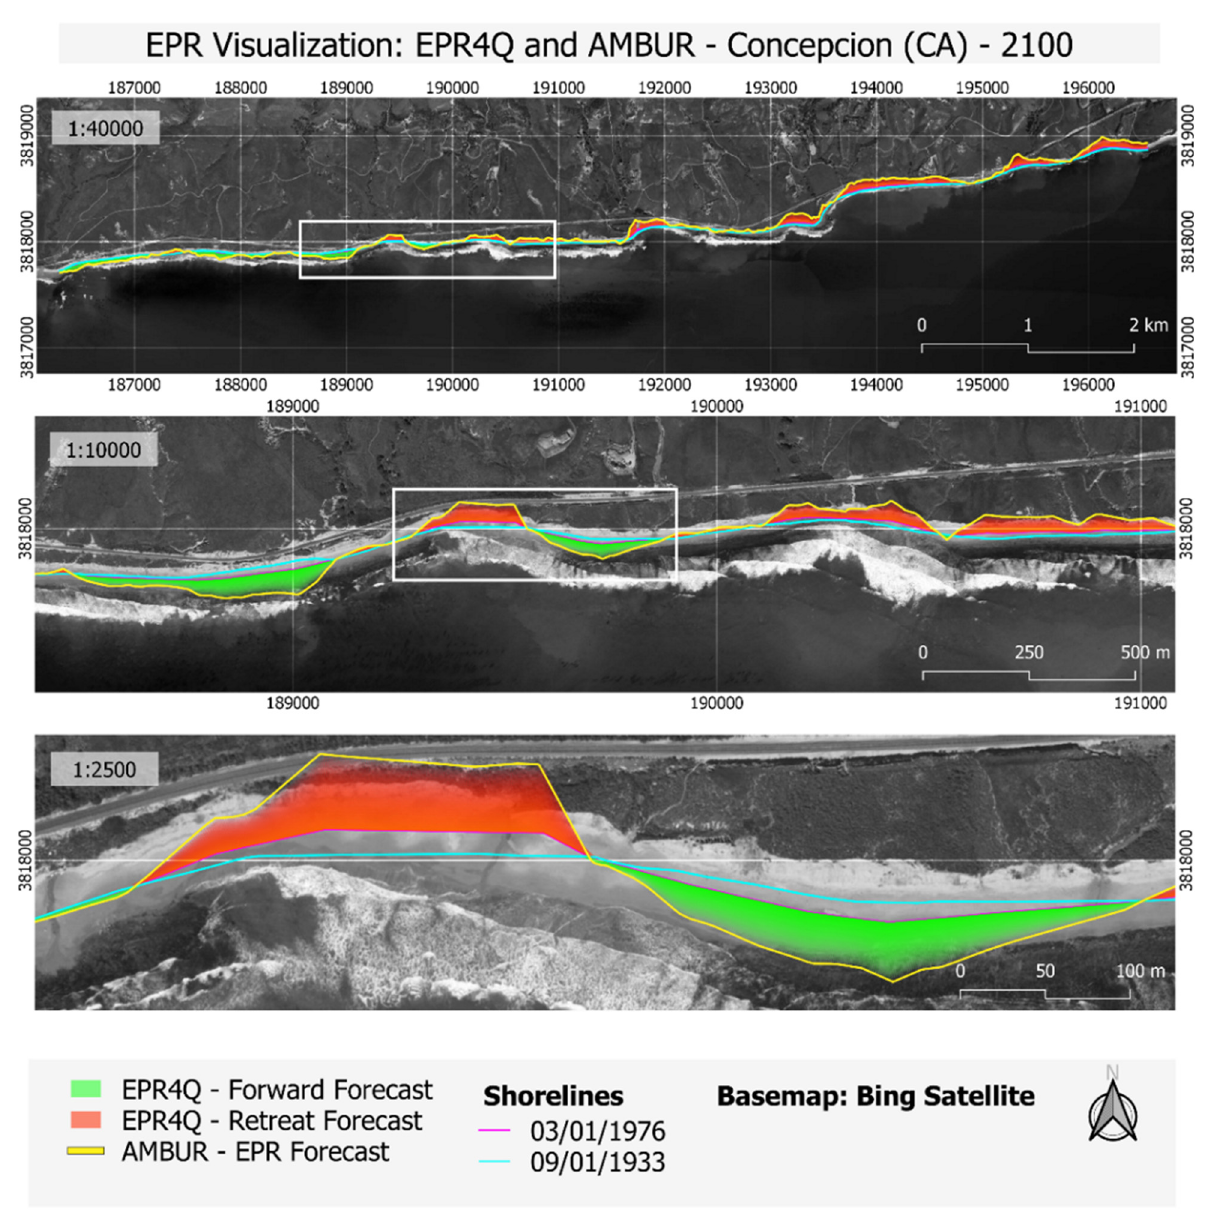
Figure 5. Visualization of EPR forecast of EPR4Q and Analyzing Moving Boundaries Using R (AMBUR) tools for 2100 in Concepcion, CA.